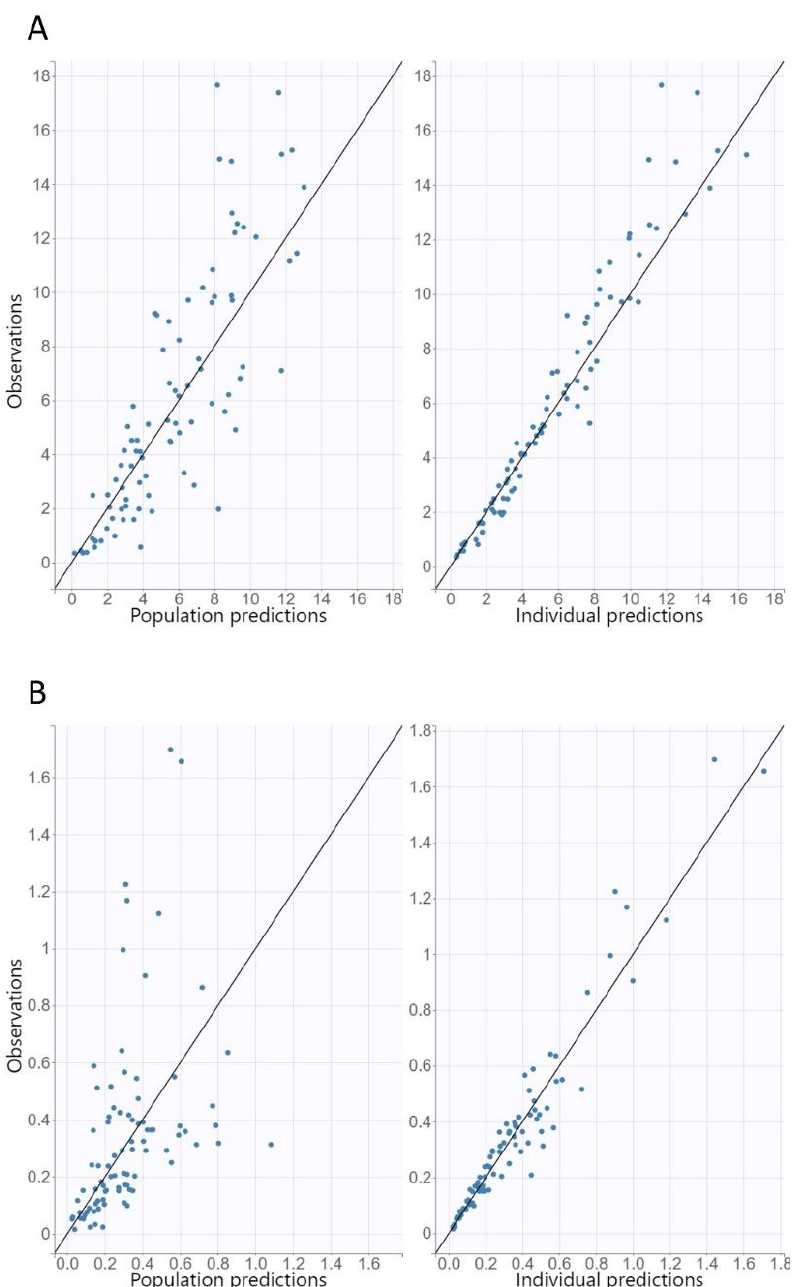
Figure 2. Population and individual predictions of ciprofloxacin ( A ) and desethylene ciprofloxacin ( B ) versus observed concentrations.